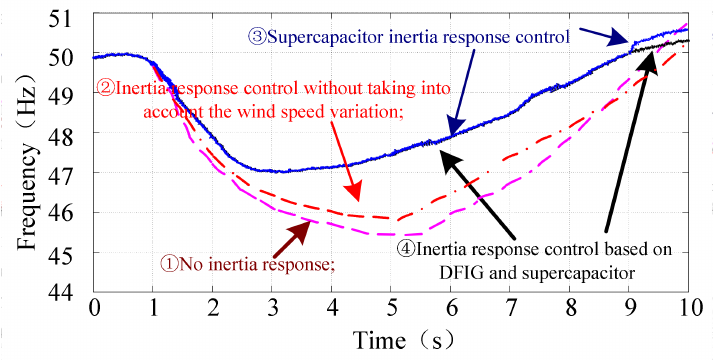
Figure 12. Comparison of the power grid frequency responses with shock load L2 added.